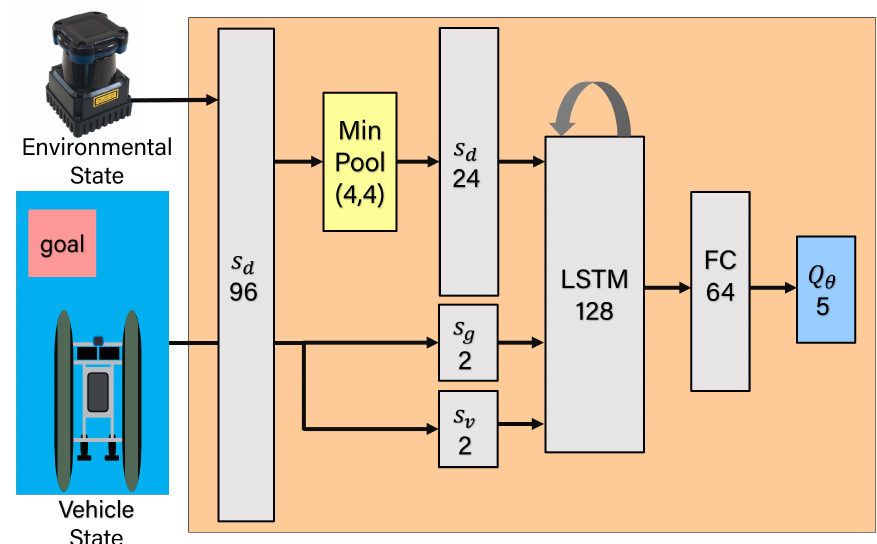
Figure 5. Architecture of the DQN model implemented in this work. This diagram shows the inputs ( s d , s g and s v ) as well layers using as part of the overal